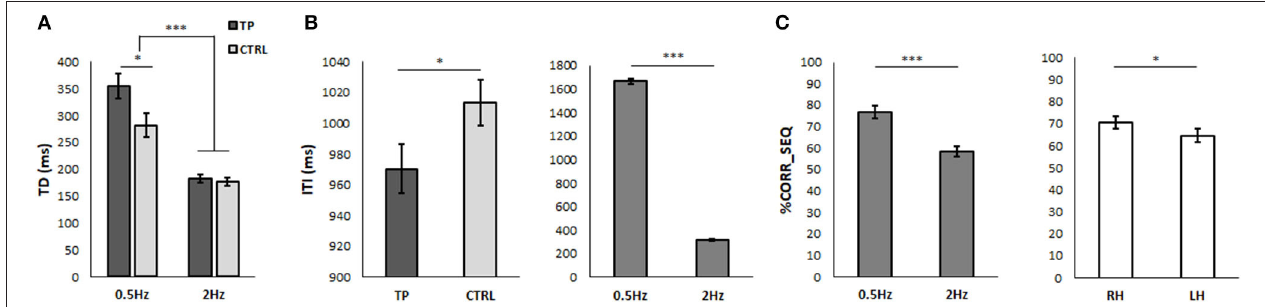
FIGURE 2 | Movement strategy (A,B) and performance accuracy (C) in the bimanual coordination test. Mean values of touch duration [TD, (A) ] and inter-tapping interval [ITI, (B) ] of tennis players (TP, dark gray) and control participants (CTRL, light gray), when the metronome was set at 0.5 and 2Hz. (C) Representation of mean values of the number of correct movements expressed as a percentage of the total sequence number (%CORR_SEQ) when the metronome was set at 0.5 and 2Hz (A) and when the task was executed with the right (RH) and left (LH) hand (B) . Error bars indicate SEM; * p < 0.05 and *** p < 0.001, respectively.